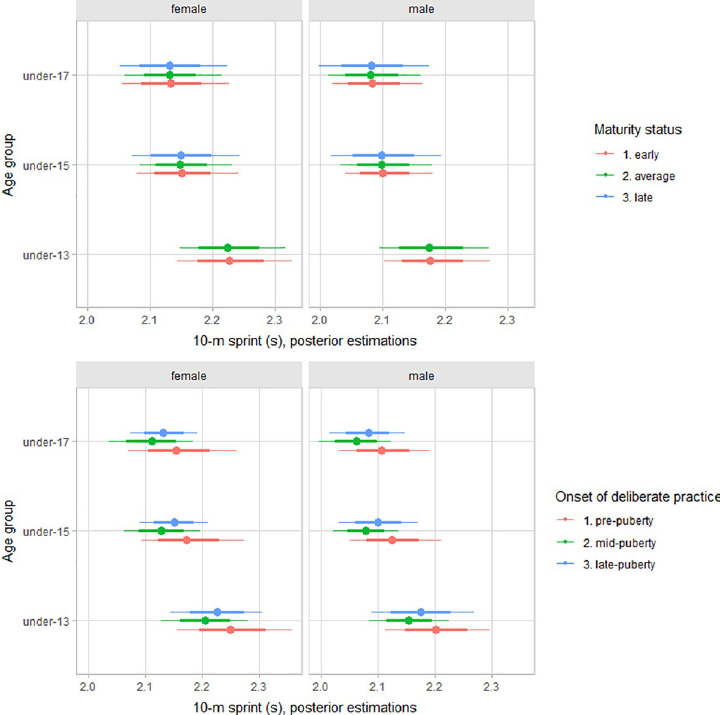
Fig 4. Posterior estimations and uncertainty (bold lines and thick ones represent 67% and 90% intervals, respectively) for 10-m sprint performance by age group and contrasting age group by maturity status (upper plot), and the onset of deliberate practice (lower